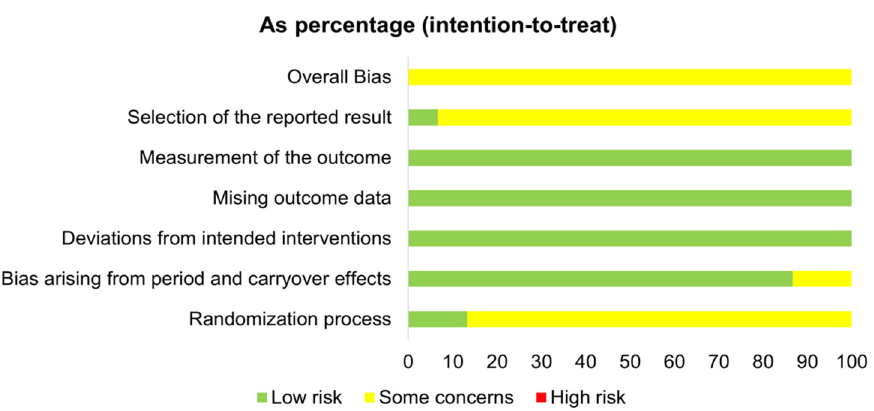
Figure 3. Risk of bias graph for the crossover trials.